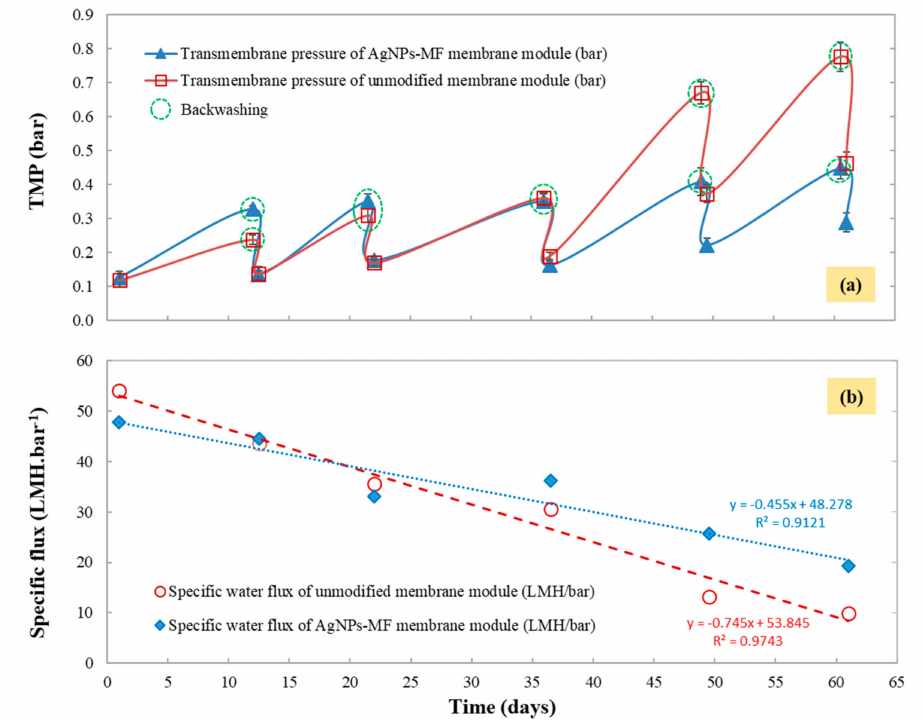
Figure 5. The variation of ( a ) transmembrane pressure (TMP) and ( b ) specific flux variation for the unmodified membrane module and the AgNPs-MF membrane